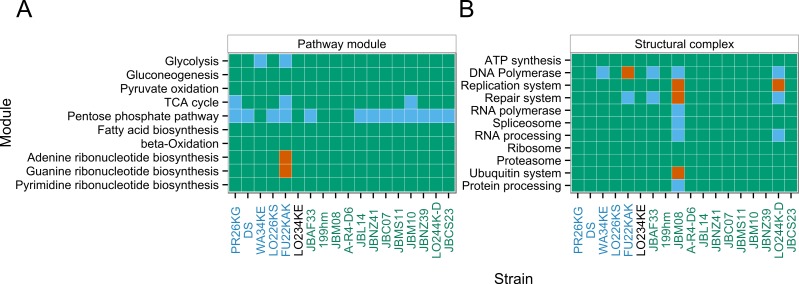
Completeness of KEGG essential modules.(A) shows pathway modules, (B) shows structural complexes. Modules are considered operational if all enzymes necessary for the reaction steps or proteins constituting a complex are present. Pathway modules are coloured in green if at most one enzyme is missing, in blue if more than one enzyme is missing, but the central module is complete (e.g., complete module: M00001 Glycolysis (Embden-Meyerhof pathway); central module: M00002 Glycolysis, core module involving three-carbon compounds) and in red if more than one enzyme and the core module are missing. Structural complexes consist of several modules, e.g., ATP synthesis consists of 22 modules. Structural complexes are coloured in green if the majority of the modules is functional, in blue if less then half of them are present and in red if the structural complex is missing. Strains on the x-axis are sorted and coloured according to Fig. 1.